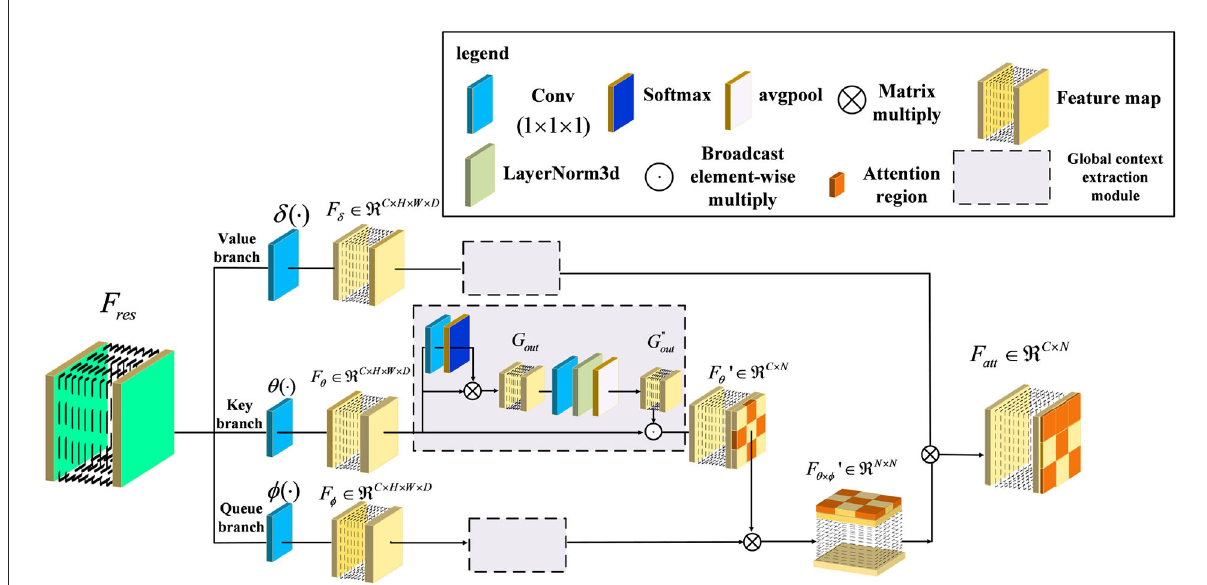
FIGURE2 Illustration of Non-local Context Spatial Attention (NCSA) block. The NCSA block consists of the global context extraction module which aggregated the global context to the spatial feature. Here, φ ( · ), θ ( · ), and δ ( · ) represent a query branch filter, a key branch filter, and a value branch filter,